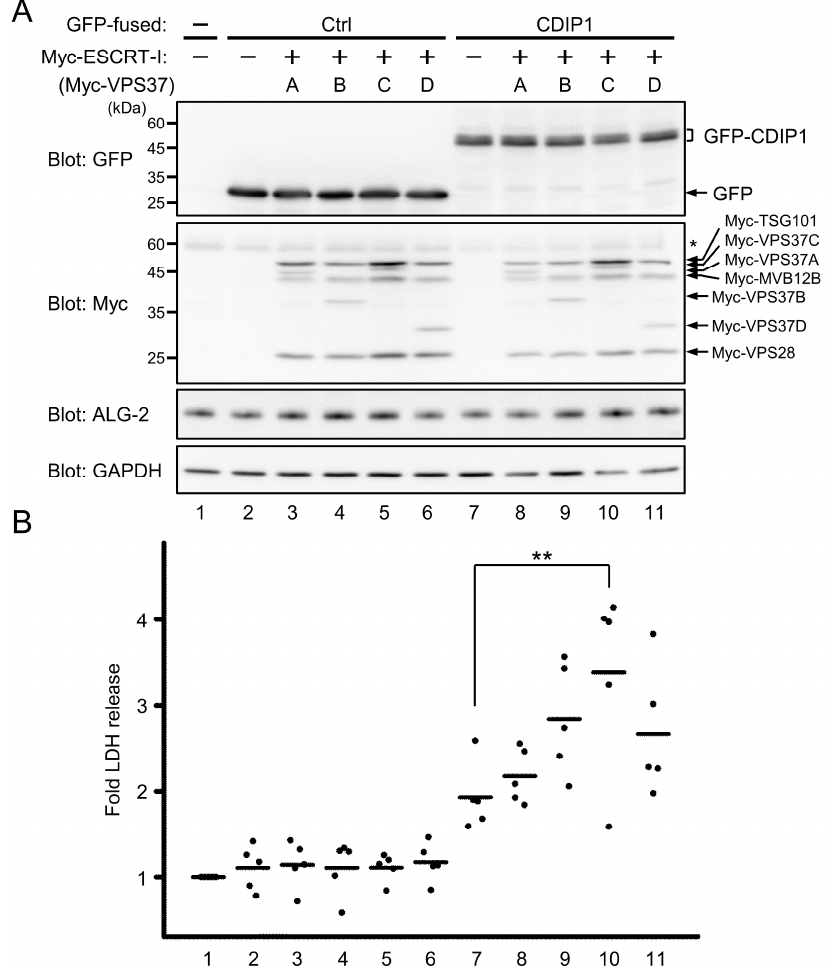
Figure 6. Promotion of CDIP1-induced cell death by ESCRT-I isocomplexes. HEK293 cells were transfected with expression plasmids for GFP (Ctrl) or GFP-CDIP1 (CDIP1) in combination with or without expression plasmids for Myc-tagged ESCRT-I subunits (Myc-TSG101, Myc-VPS28, Myc-MVB12B and each isoform of VPS37A-D). Mock-transfected cells were used as a reference to calculate the relative release of lactate dehydrogenase (LDH). ( A ) Representative results of WB analysis of protein levels of GFP-CDIP1, Myc-tagged proteins and ALG-2 in cells at 24 h after transfection. GAPDH was detected as a loading control. A single asterisk (*) indicates the migration position of the endogenous Myc protein. ( B ) Cell death was monitored by measuring the amounts of LDH released into the medium. Values are expressed as fold LDH release into the medium compared with that of mock-transfected cells. Five independent repetitive experiments were performed and data are expressed as dot plots with means (bar). Statistical significance by one-way ANOVA followed by Tukey’s test is indicated by asterisks (** p <